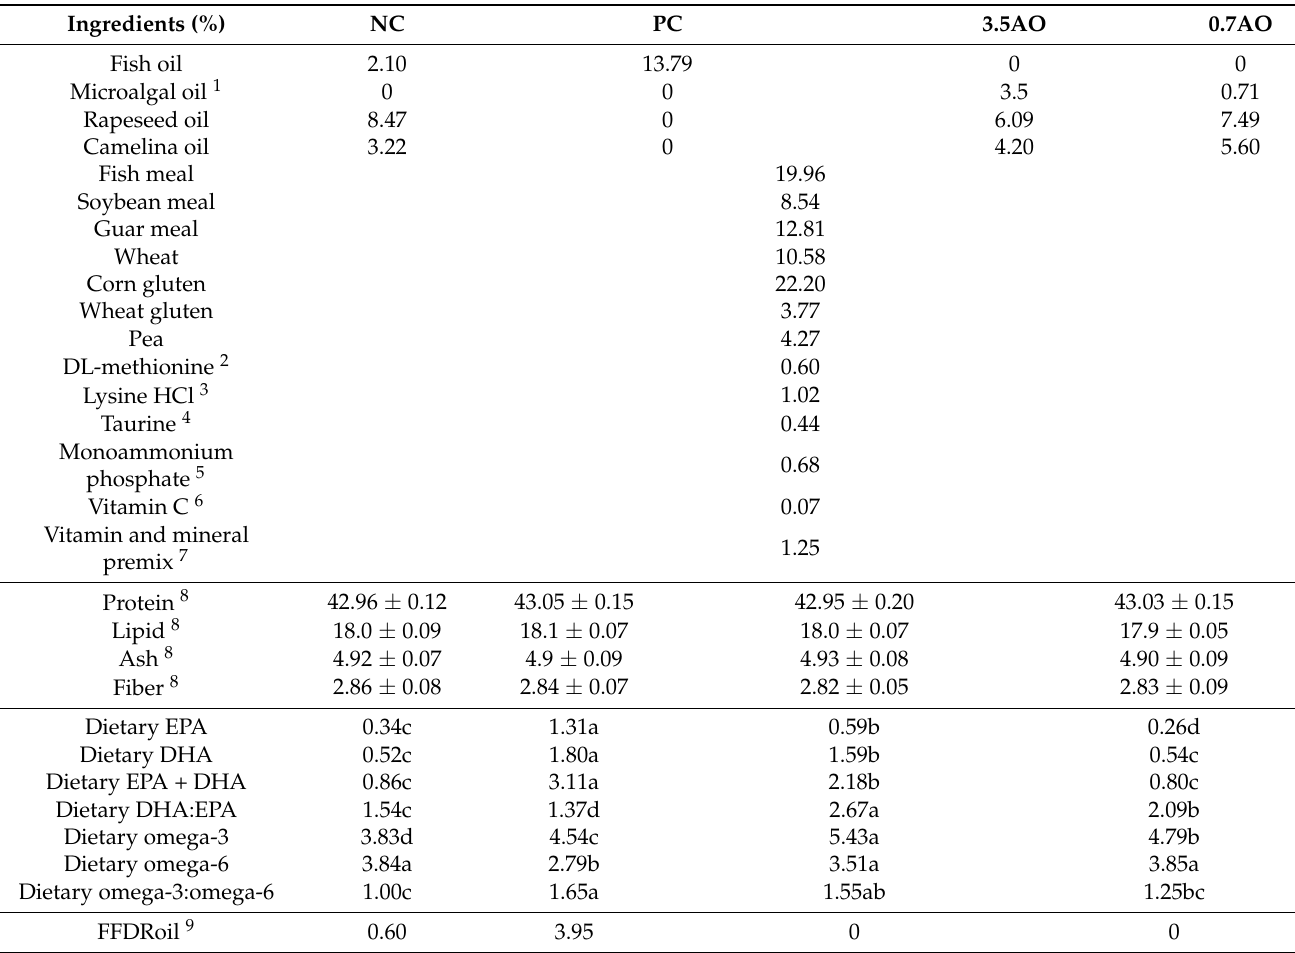
Table 1. Formulation of the experimental diets. Different letters show significant differences ( p < 0.05) between the experimental treatments, while shared letters signify no significant